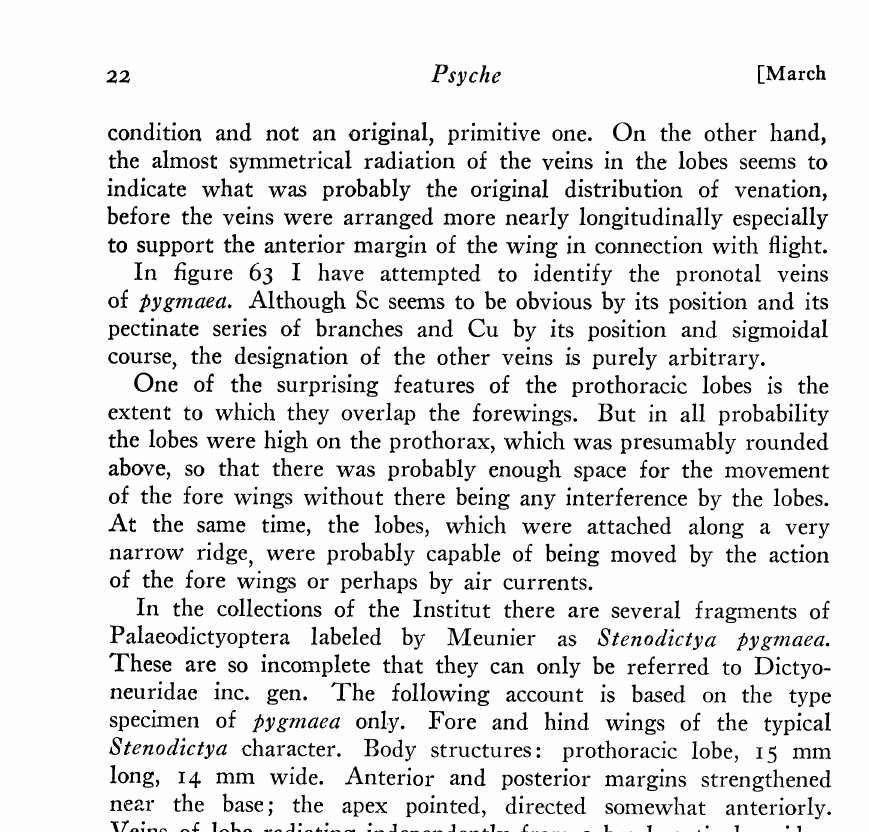
Figure 63 Stenodictya Irandissima Meunier, 1911: 121, fig. 4; Meunier, 1912: